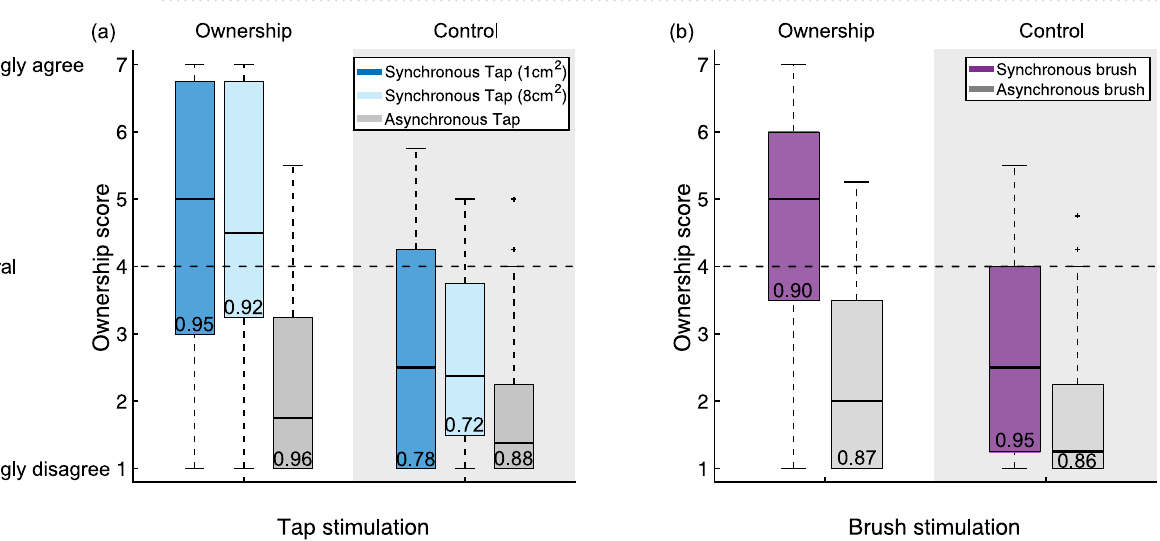
Figure 3. Questionnaire answers by four participants with transhumeral amputation after both the synchronous and asynchronous administration of visuo-tactile neural stimulation involving their prosthesis, and visuo-tactile feedback involving a rubber hand and their intact contralateral hand. Questions 1–4 inquired ownership over the prosthesis, whereas questions 5–8 were control questions. The dotted line indicates the mid- point of the Likert scale.